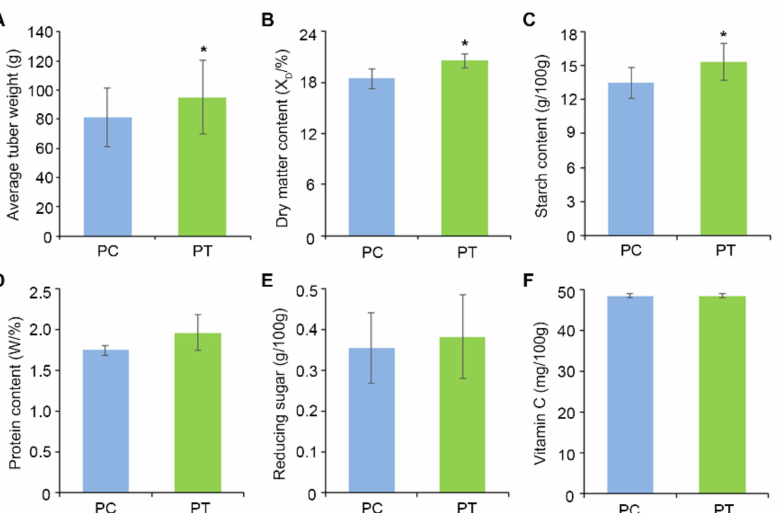
Figure 8. Effect of biocontrol treatment on potato tuber yield and quality. ( A ) Bar chart of average tuber weight. n = 18 ( B ) Bar chart of dry matter. ( C ) Bar chart of starch content. ( D ) Bar chart of protein content. ( E ) Bar chart of reducing sugar content. ( F ) Bar chart of vitamin C content. Asterisks indicate statistically significant differences at p < 0.05 according to t